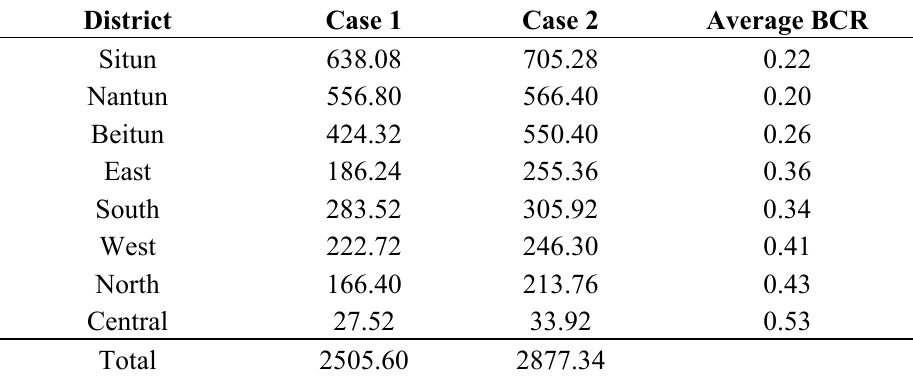
Table 6. Inundation area of Taichung City (unit: